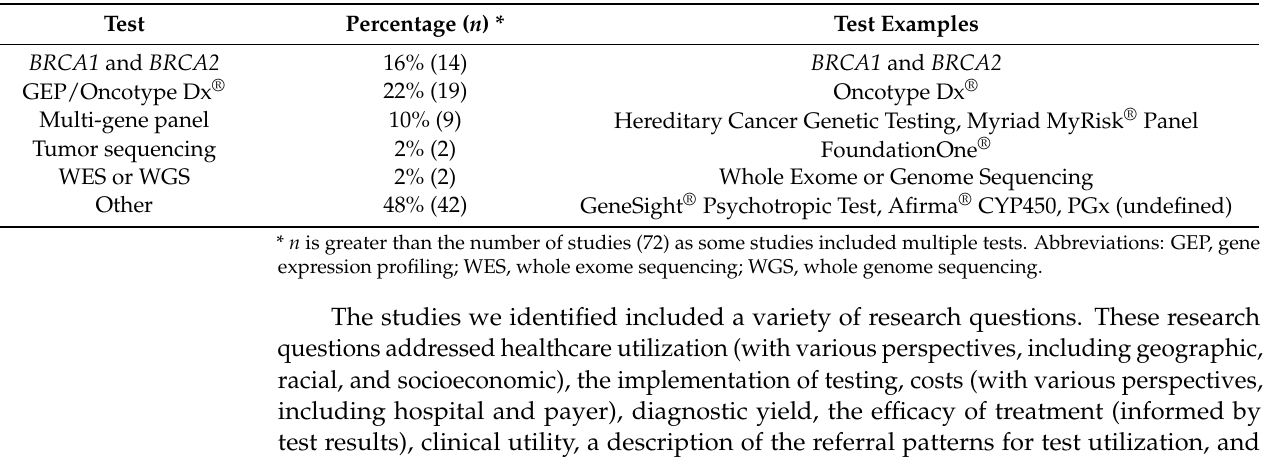
Table 2. Percentage of test types and examples ( n = 88)